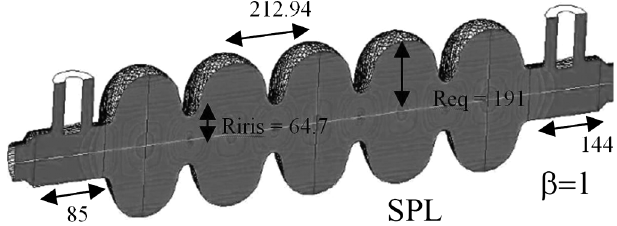
FIG. 8. 704 MHz SPL cavity to be electropolished in the VEP